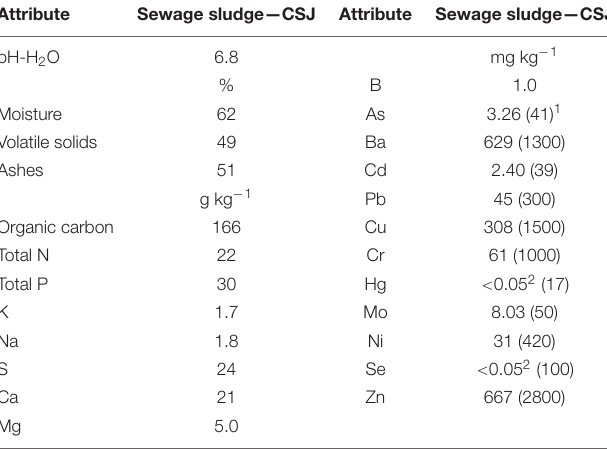
TABLE 2 | Sewage sludge chemical features and PTE